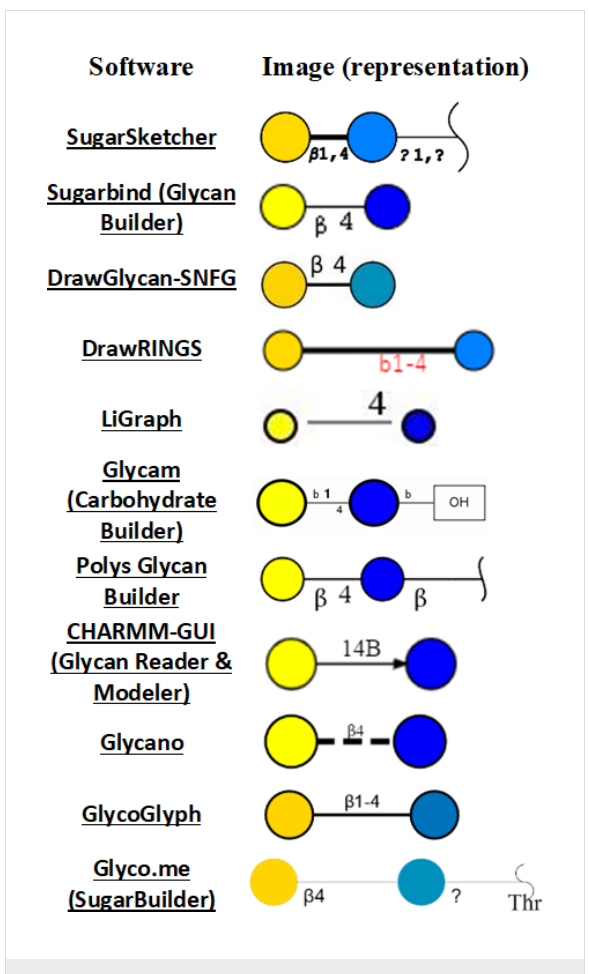
Figure 2: Depiction of lactose by various glycan sketching tools.